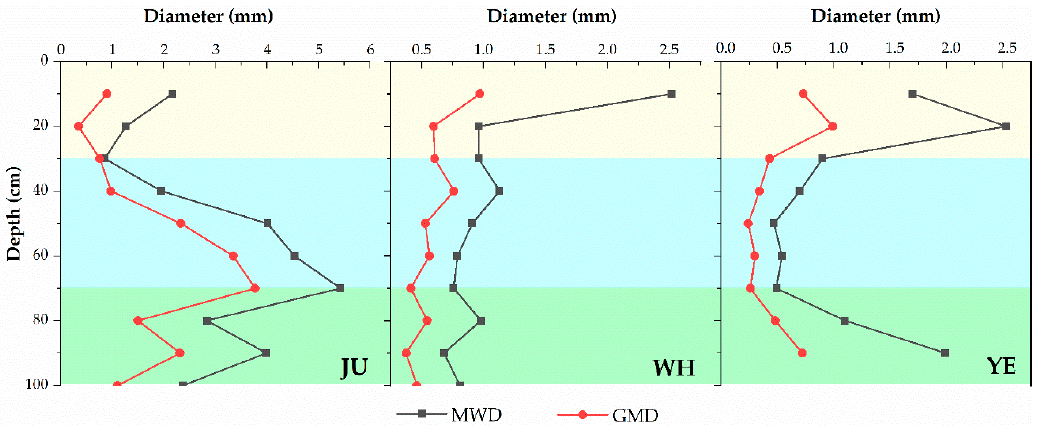
Figure 7. Mean weight diameter ( MWD ) and geometric mean diameter ( GMD ) of plinthosol in the JU, WH, and YE profiles.